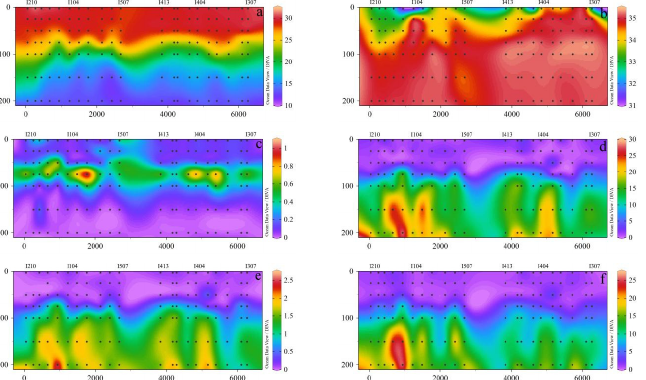
Figure 2. The vertical distributions of ( a ) temperature (°C), ( b ) Salinity (psu), ( c ) Chlorophyll a ( μ g/L), ( d ) DIN ( μ mol/L), ( e ) DIP ( μ mol/L), ( f ) DSi ( μ mol/L) in the eastern Indian Ocean in spring 2017. The bottom x axis was a straight line distance between two stations, and the top x axis was the station. Dissolved Inorganic Nitrogen (DIN), Dissolved Inorganic Phosphorus (DIP), Dissolved Silicate (DSI).